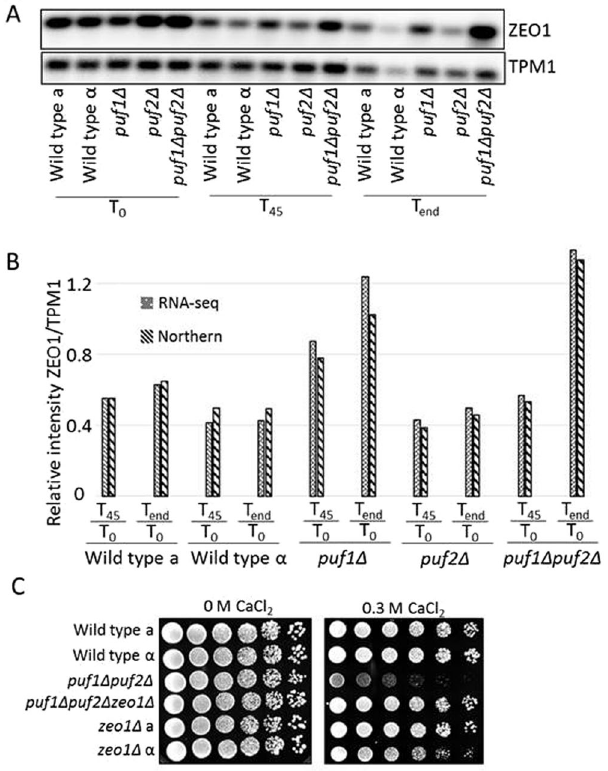
Figure 8. Effect of ZEO1 deletion on cell growth under CaCl 2 stress. ( A ) Total RNA was extracted from the indicated strains at the indicated times and subjected to northern analysis with probes for Zeo1 and TPM1 as a control. ( B ) Bar diagram shows the ratio of ZEO1 versus TPM1 transcripts from quantification either by northern blot or RNA-seq of expression in the same biological replicate. ( C ) Cells from the indicated strains were diluted to OD 600 1.0, and five-fold serial dilutions were spotted onto YPD agar with the indicated CaCl 2 concentrations and were incubated at 30 °C for two days without CaCl 2 or three days with CaCl 2